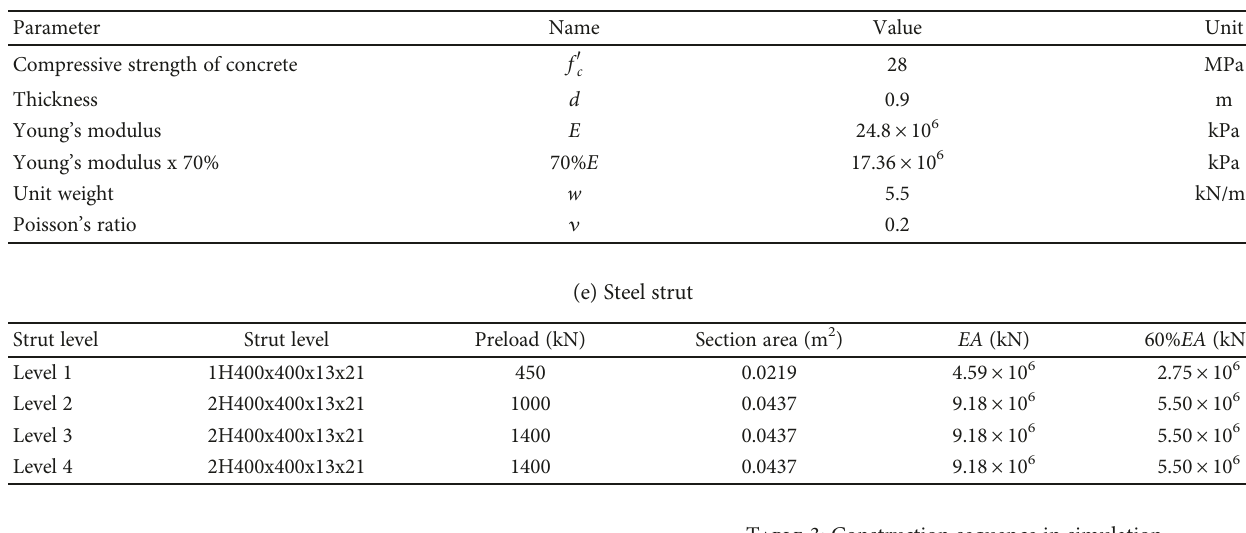
Table 3: Construction sequence in